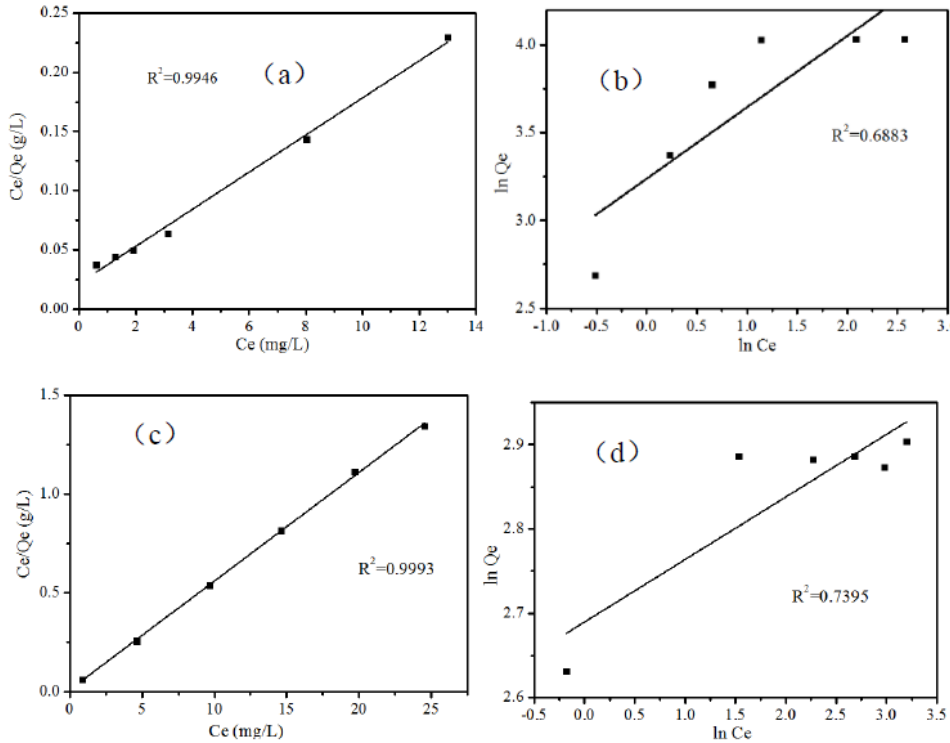
Figure 7. The linearized of Langmuir adsorption isotherm ( a ) MB ( c ) RhB and Freundlich adsorption isotherm ( b ) MB ( d ) RhB adsorption by B-TiO 2 /C 3 N 4